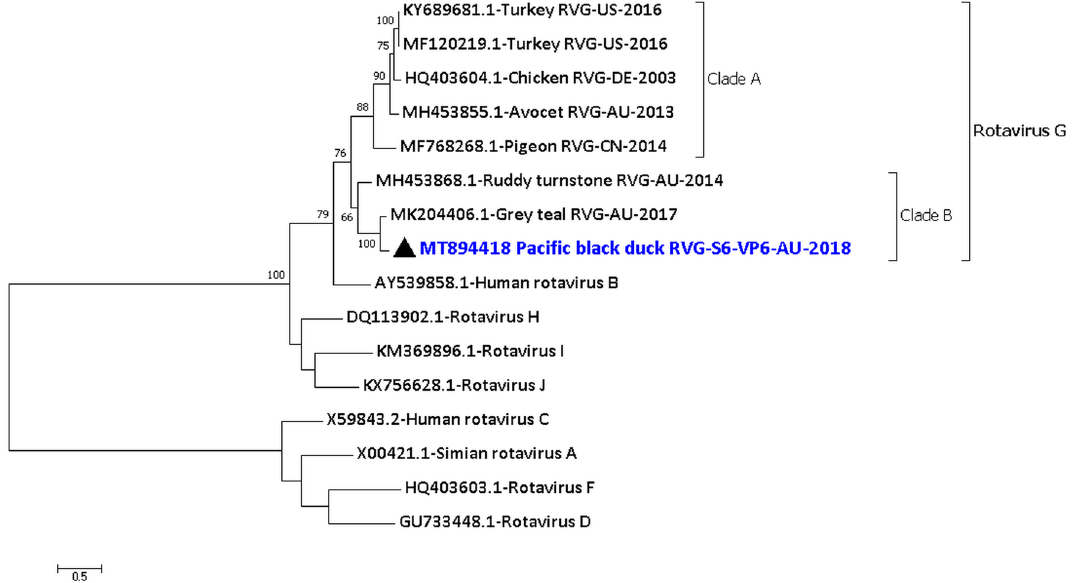
Figure 4. Phylogenetic analysis of the amino acid sequences of the VP6 protein of Pacific black duck rotavirus G segment S6 (PBDRVG/PBD08.18). The amino acid sequences were aligned and analysed by using the maximum likelihood method based on the LG + G + F model 72 in MEGACC 74 with a bootstrapping of 1000 replicates. The analysis involved 16 amino acid sequences and all positions containing gaps and missing data were eliminated. The final dataset contained a total of 371 amino acid positions. The numbers at the nodes represent bootstrap values and only bootstrap values at or above 60% are shown. Pacific black rotavirus G is shown in blue and marked with a black